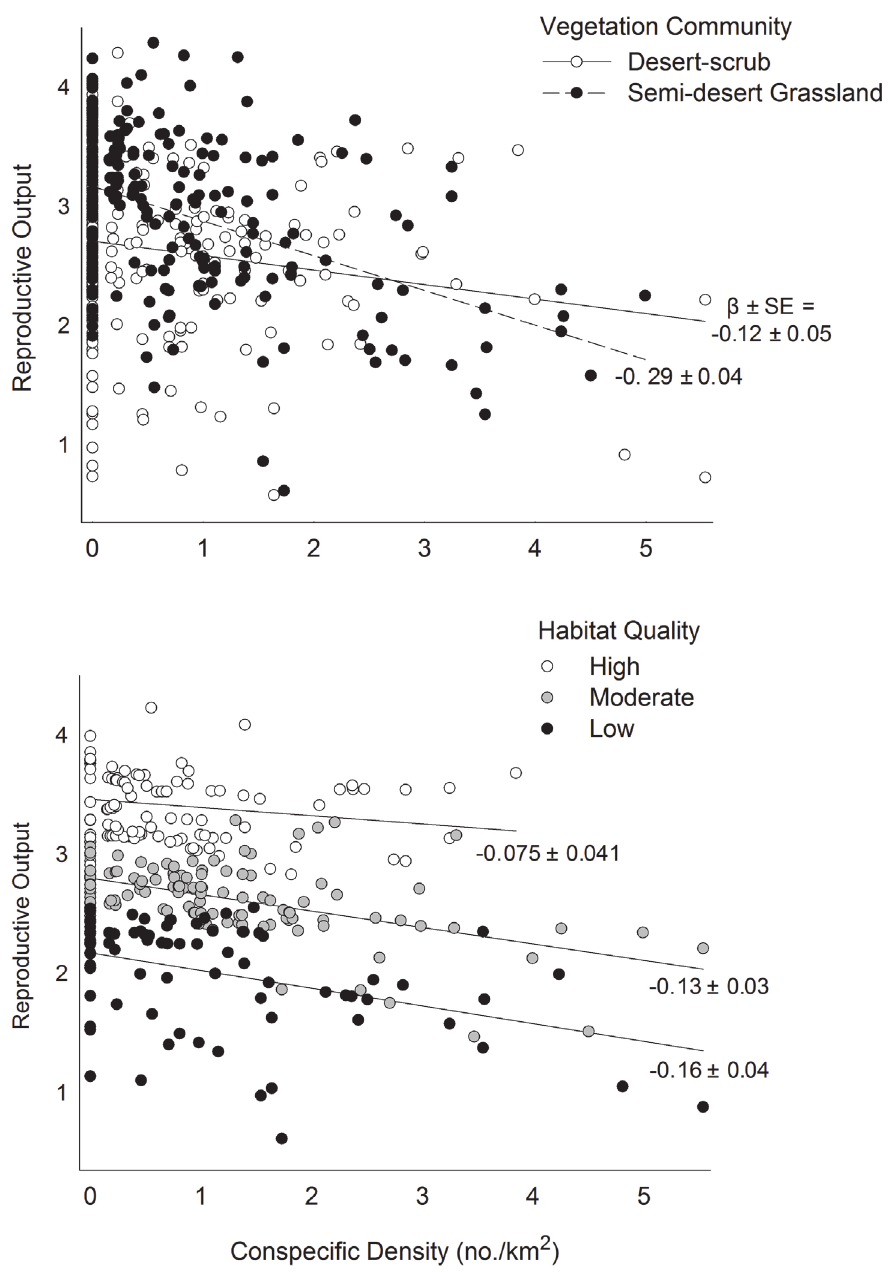
Fig 9. Effects of vegetation community and fundamnetal habitat quality on density-dependent declines in reproductive output of ferruginous pygmy-owls in northwest Mexico, 2001 – 2010. Habitat quality was classified as high ( > 3.0), moderate ( > 2.4 – 3.0), or low (0.9 – 2.4) based on patch-specific predictions of reproductive output from model 3 in Table 3. Slope parameters and SE are from least-squares regression. Estimates are based on the model {Habitat × Density + Weather} in Table 6 and S5